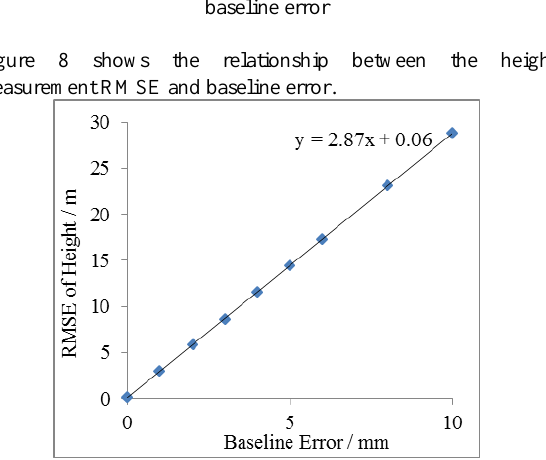
Figure 8. Relationship between the height RMSE and baseline